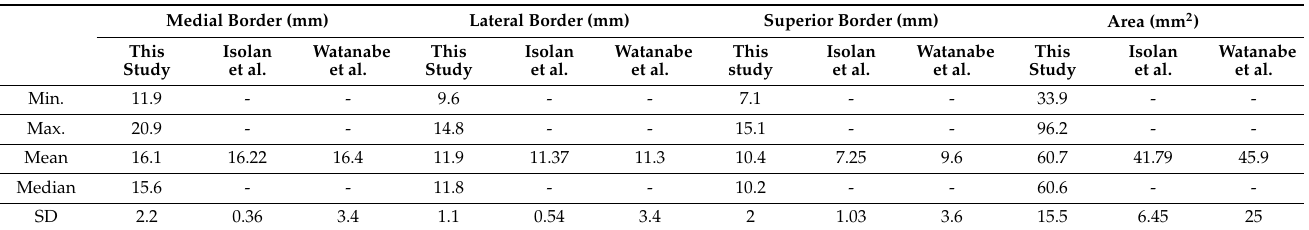
Table 1. Basic descriptive statistics (minimum value, maximum value, median and standard deviation) for the area and measurements of the inferomedial triangle, including comparisons with data obtained by Watanabe et al. [3] and Isolan et al. [4].